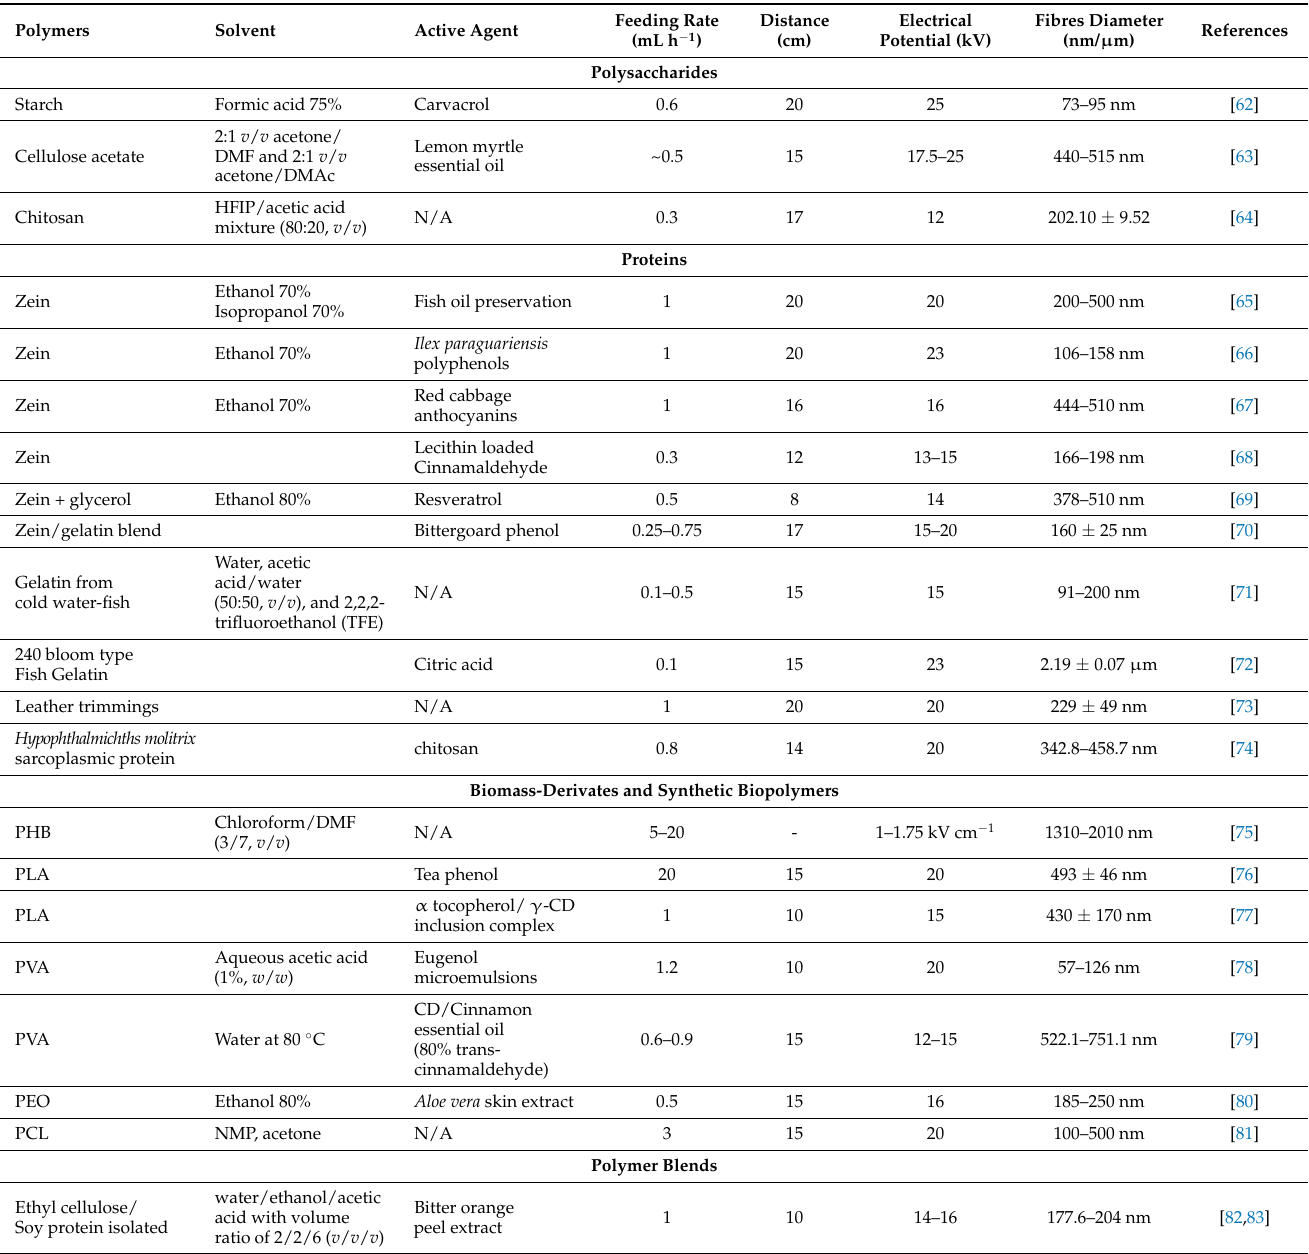
Table 1. Summary of electrospinning process for food processing and